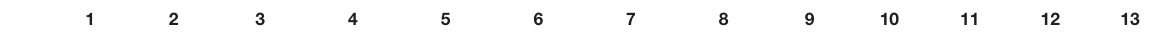
TABLE 6 | Correlations among different motivations—United States participants.